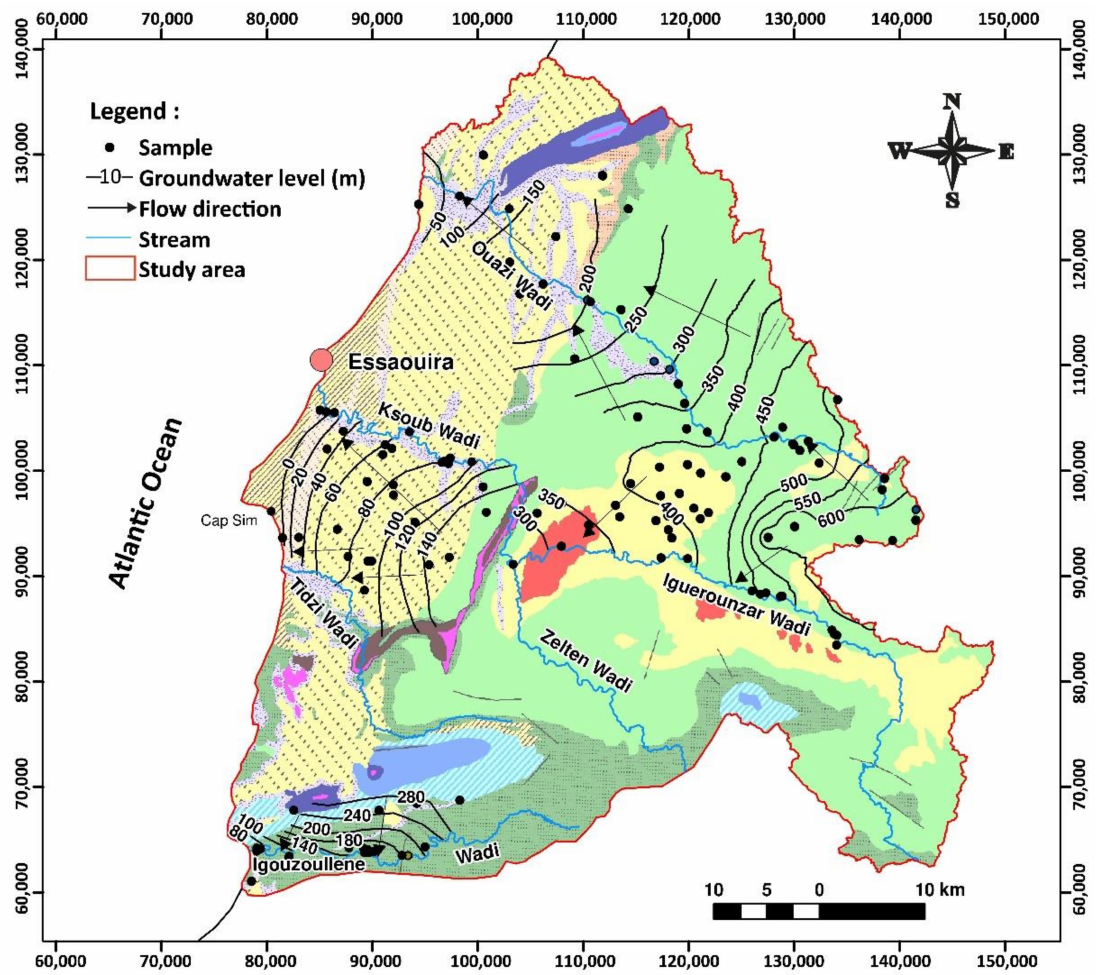
Figure 7. Piezometric map of the study area (campaign of